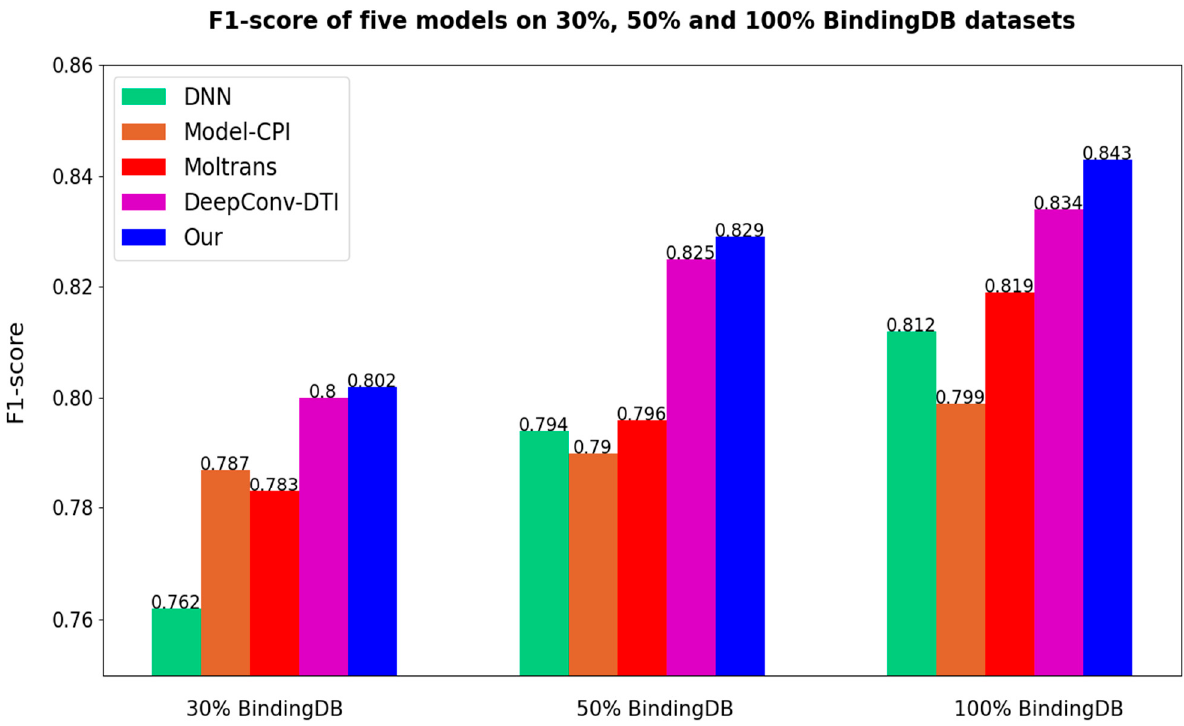
Figure 8. Comparisons of different models on F1-socre (Our = Multi-TransDTI).